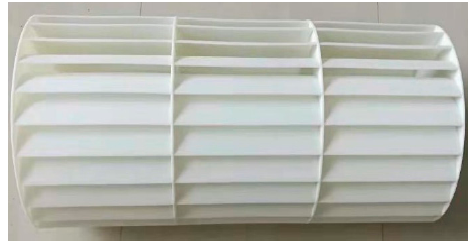
Figure 6. Horizontal axis rotor.